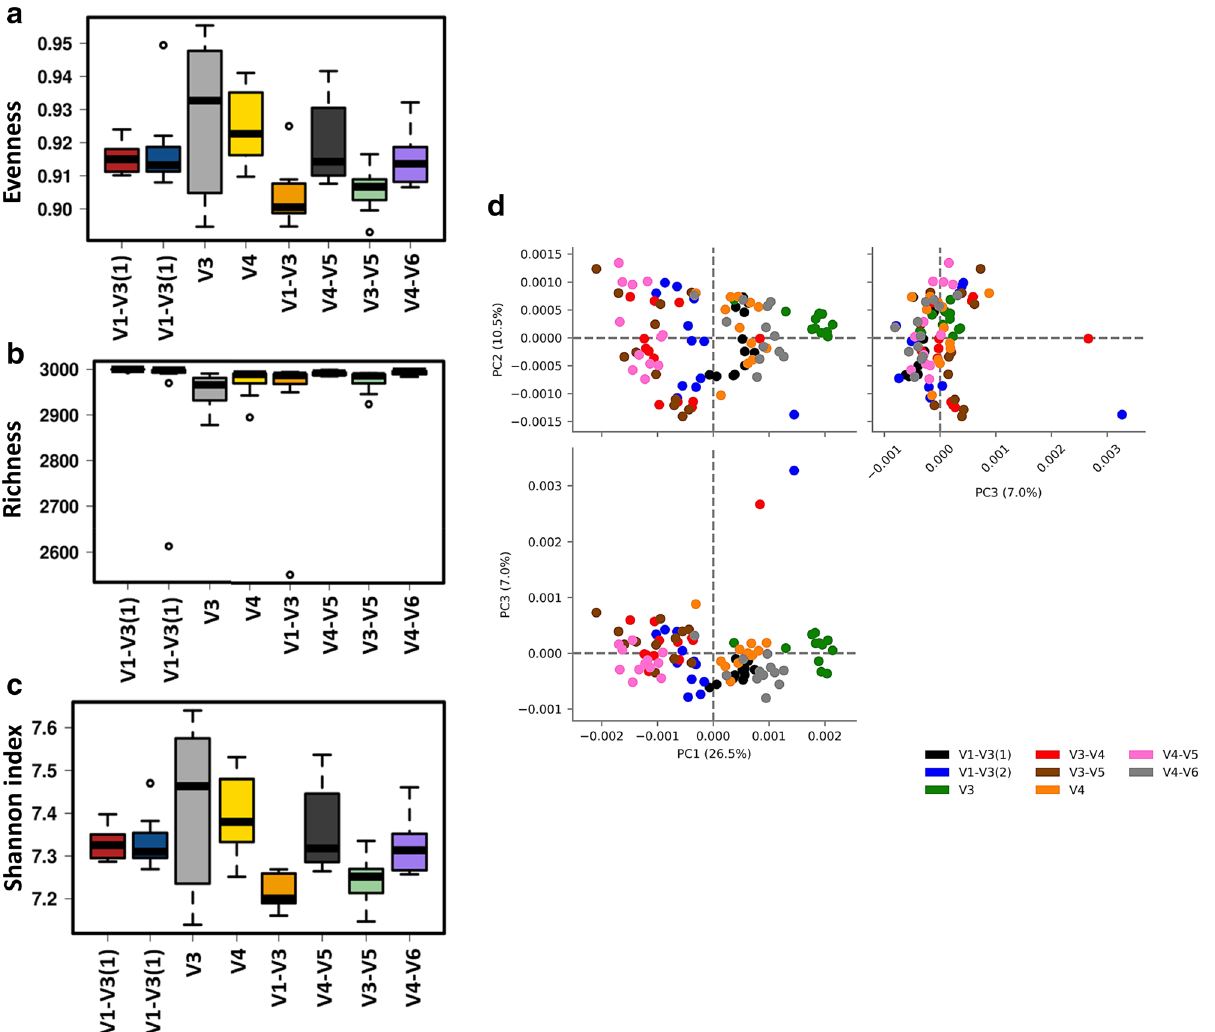
Figure 6. Effect of the primer set on alpha and beta diversities of predicted function of the cecal microbiota in chickens. Function of the microbiota was determined using PICRUST and visualized using Calypso (a–c) and STAMP (d) . Alpha diversities: (a) evenness ( P < 0.001), (b) richness ( P = 0.33) and (c) Shannon index ( P < 0.0001) (d) beta diversity between primer set bacterial populations was determined using principal component analysis